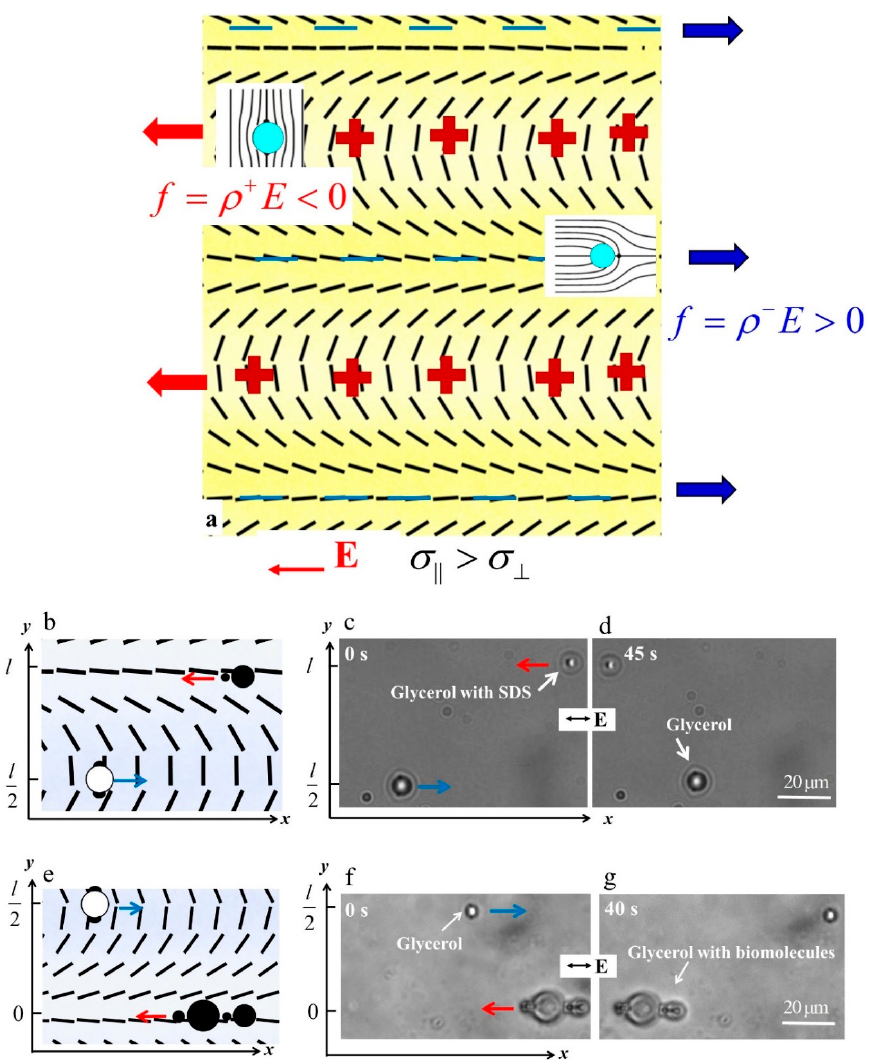
Figure 14. Sorting of fluid droplets with different surface properties by LCEO flows in patterned nematic cells by a method proposed by Peng et al. [70]. ( a ) Scheme of the director field, charge separation and preferential location of the colloids: spheres with normal anchoring accumulate in regions of splay, spheres with tangential anchoring accumulate in the regions of bend; ( b – d ) Sorting of droplets of pure glycerol (tangential anchoring) and glycerol with the surfactant SDS (perpendicular anchoring) by the applied AC electric field; The glycerol droplets with SDS in the splay region move to the left, while the pure glycerol droplets in the bend regions move to the right; ( e – g ) Sorting of droplets of pure glycerol and glycerol with biomolecules by the applied AC electric field; The biomolecules used are DLPC which are found in bio-membranes. Adapted with permission from [70].